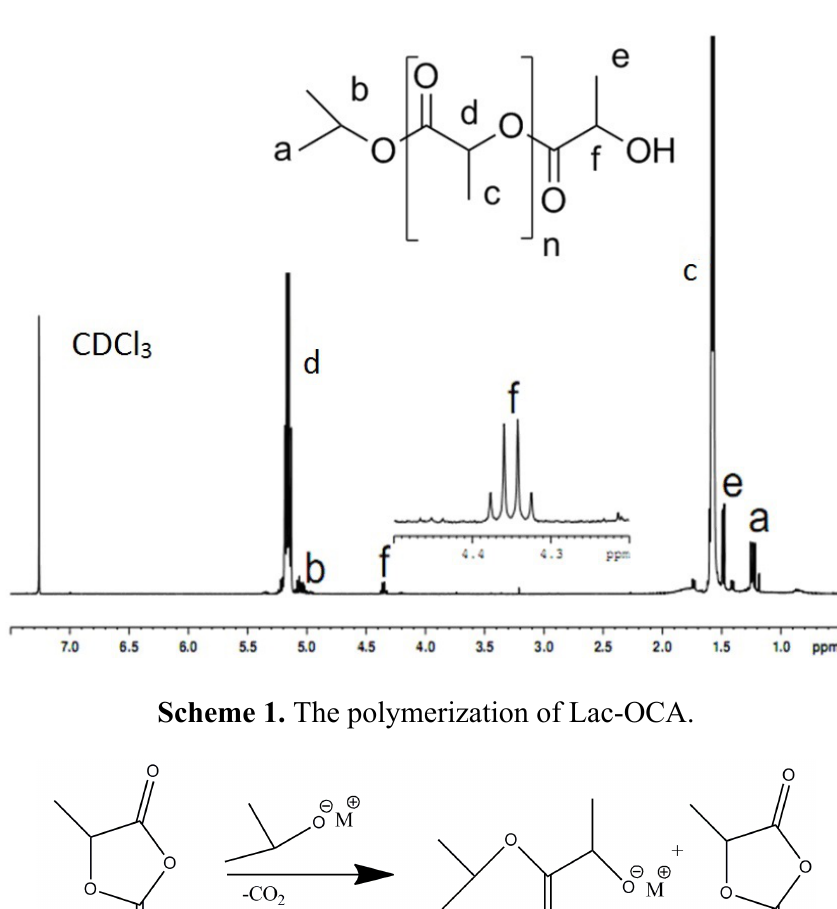
Figure 1. 1 H-NMR spectrum of PLA (the PLA was synthesized in toluene-THF (toluene/THF = 2), Lac-OCA concentration = 1.67 mol/L, M/I = 150, temperature = 25 °C and reaction time = 4